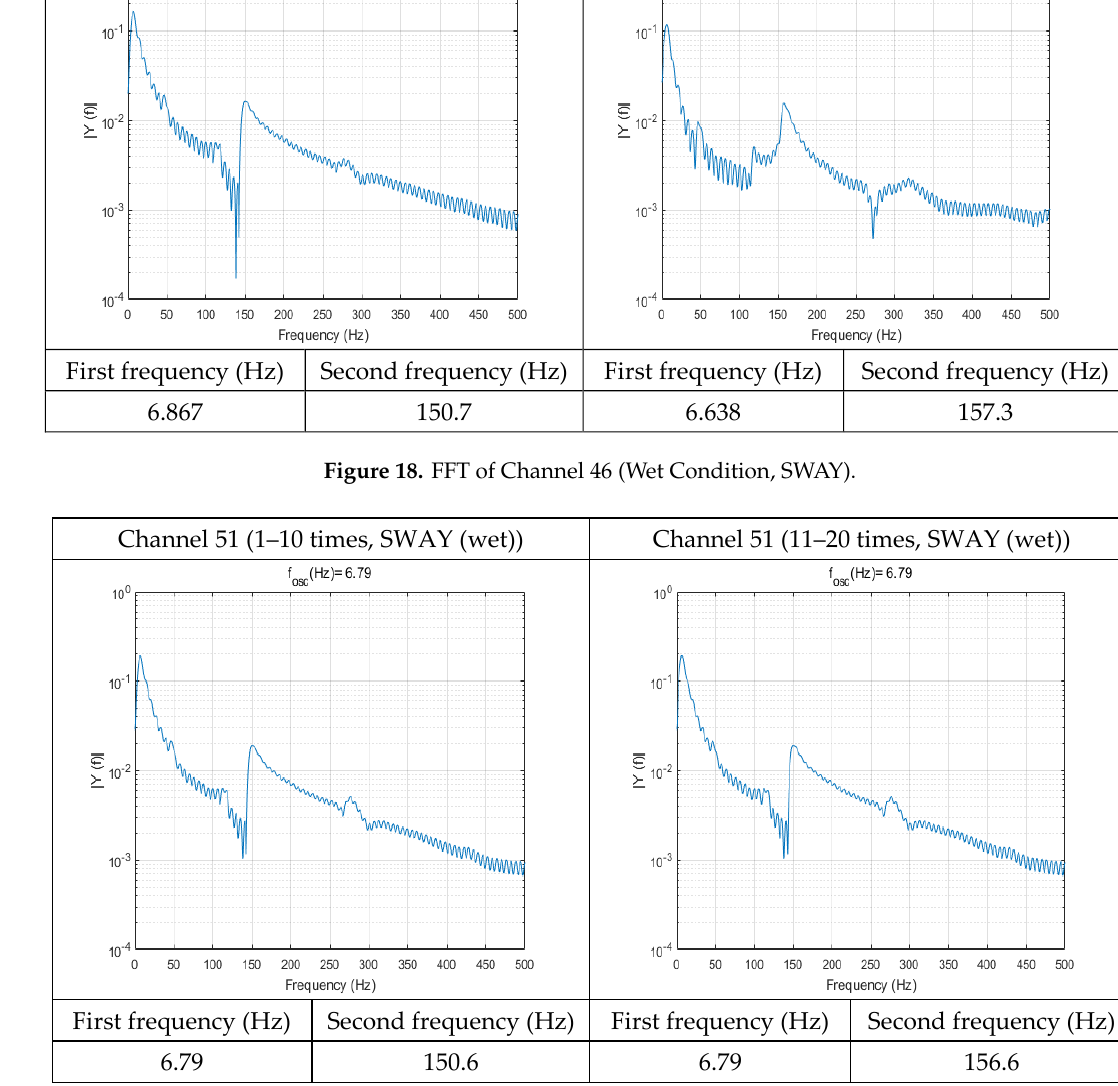
Figure 19. FFT of Channel 51 (Wet Condition, SWAY)